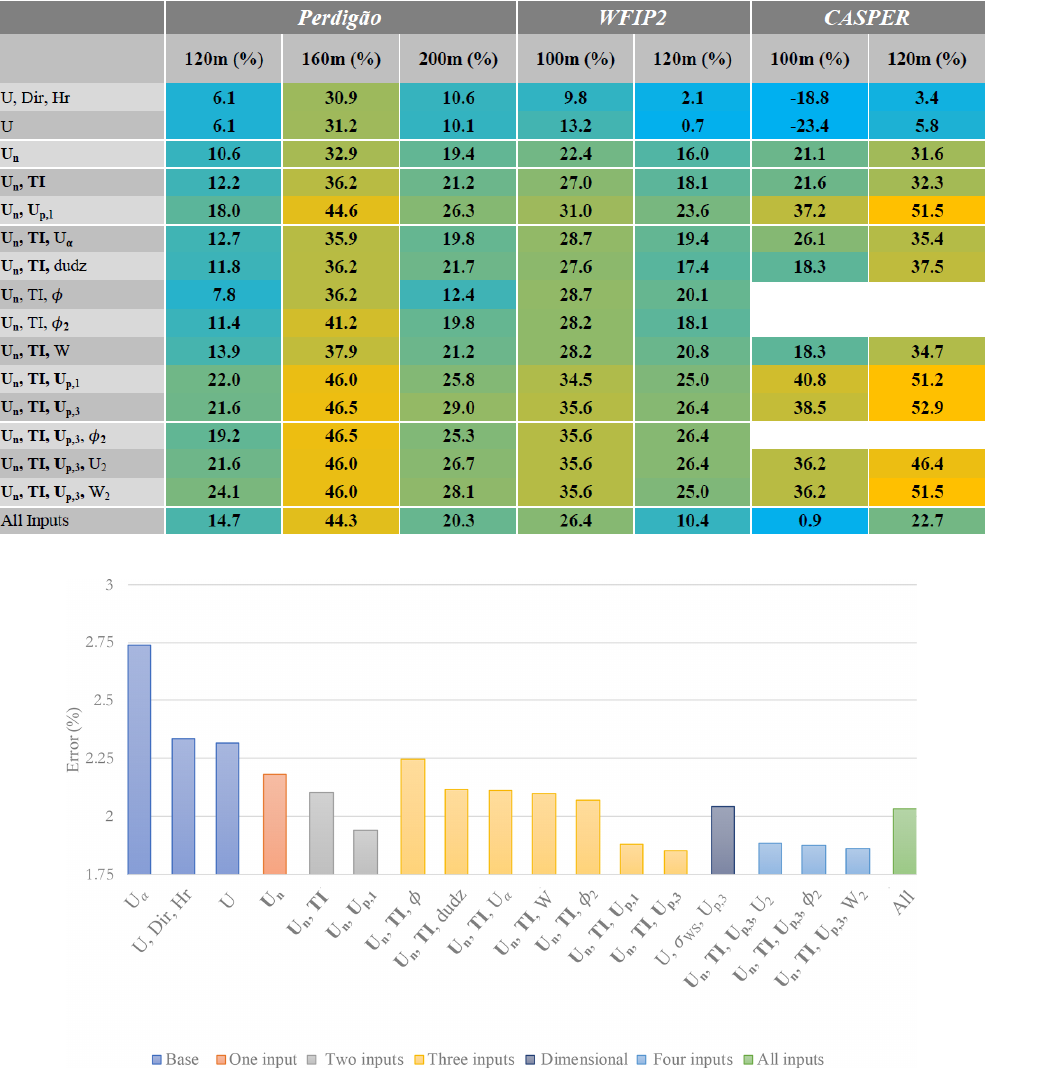
Figure 3. MAPE at Perdigão averaged over all heights. Color coding describes the number of input features used for the ANN. The dark blue bar indicates an additional test for comparison. Log-law extrapolation (4.3% average MAPE) excluded for